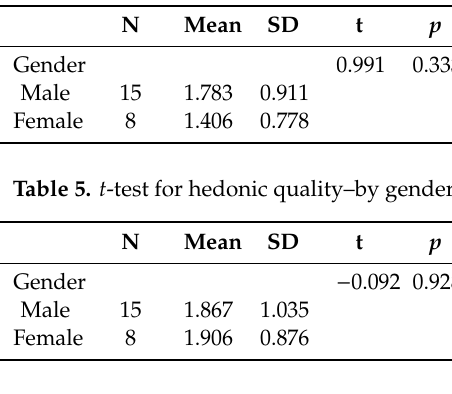
Table 4. t -test for pragmatic quality by gender.